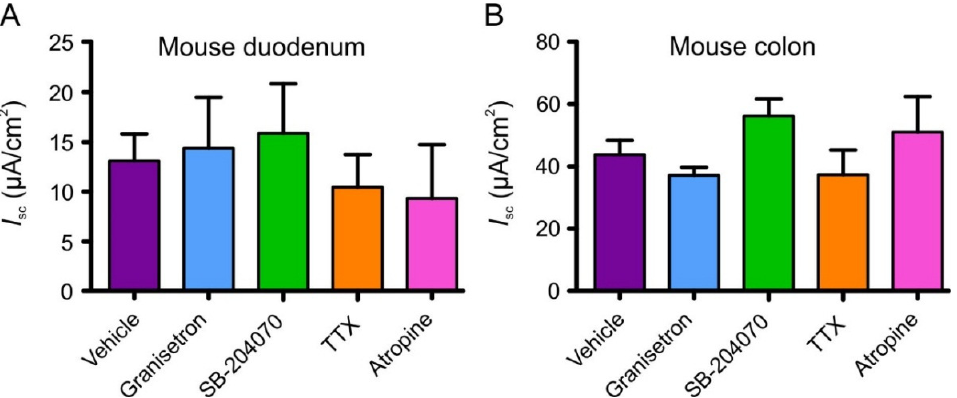
Figure 7. Effect of AITC (100 μ M) on I sc following a 20 min incubation period with antagonist in mouse duodenum ( A ) and colon ( B ). Tissues were incubated with granisetron, SB ‐ 204070, TTX, atropine and their vehicle (5 μ L dH 2 O) for 20 min. No change in I sc was observed in response to the AITC vehicle (5 μ L DMSO) after a 20 min incubation with 5 μ L added water (data not shown). No statistically significant difference was found between experimental groups using a one ‐ way ANOVA.